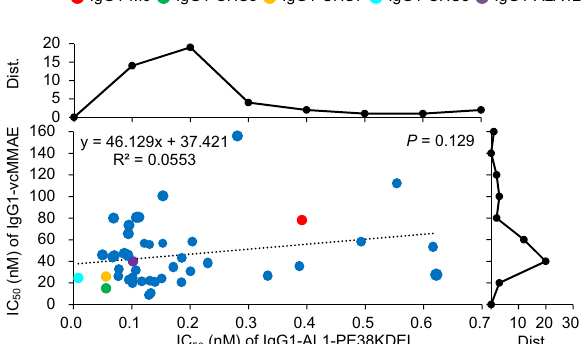
Figure 5. IC 50 ’s of IgG1-vcMMAEs and IgG1-AL1-PE38KDEL. The IC 50 ’s (nM) of the IgG1-vcMMAEs (y-axis) with the IgG1s reformatted from the selected subset of the scFv CDR-variants of M9 are plotted versus the IC 50 ’s (nM) of the IgG1-AL1-PE38KDELs (x-axis). Cytotoxicity data measured with N87 cultured cells were used to calculated the IC 50 ’s of these immunotoxins and ADCs. The distribution curve above the scatter plot shows the number of IgG1-AL1-PE38KDEL (y-axis) at each bin of the IC 50 (nM) (x-axis); the distribution curve at the right-hand side of the scatter plot shows the number of IgG1-vcMMAE (x-axis) at each bin of the IC 50 (nM) (y-axis). The data points for IgG1-M9, IgG1-CHS5, IgG1-CHS7, IgG1-CHS8 and IgG1-ALA12 are colored in red, green, orange, cyan and purple respectively. Numerical data and CDR sequences for each of the data points are shown in Supplementary Table